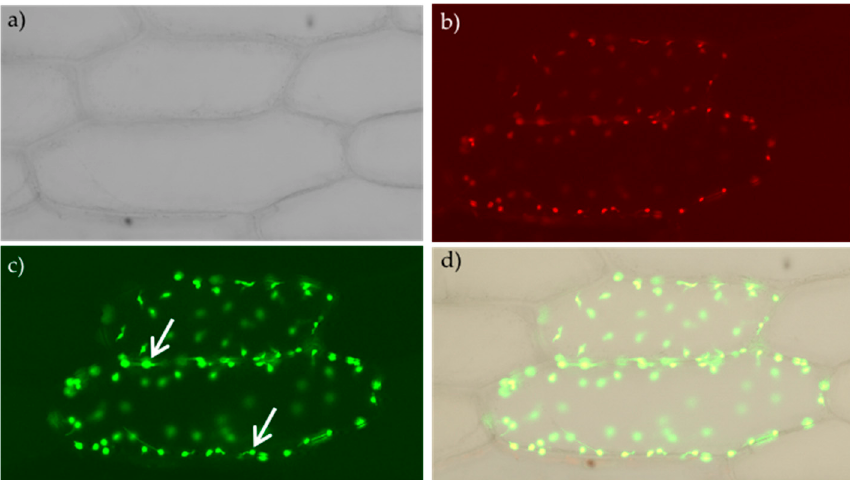
Figure 4. Transient expression of HvFC1 -GFP fusion protein in onion epidermal cells. ( a ) Bright field image. ( b ) Red-fluorescent signal from plastid localised AtHEMA2-RFP. ( c ) GFP fluorescence from HvFC1 -GFP was located on either irregularly or oval-shaped structures that are typical of onion cell proplastids and their associated stromules (arrows). ( d ) Merged channels showing green and red colocalisation as yellow. Image was taken 24 h after bombardment. Bar 100 μ m.